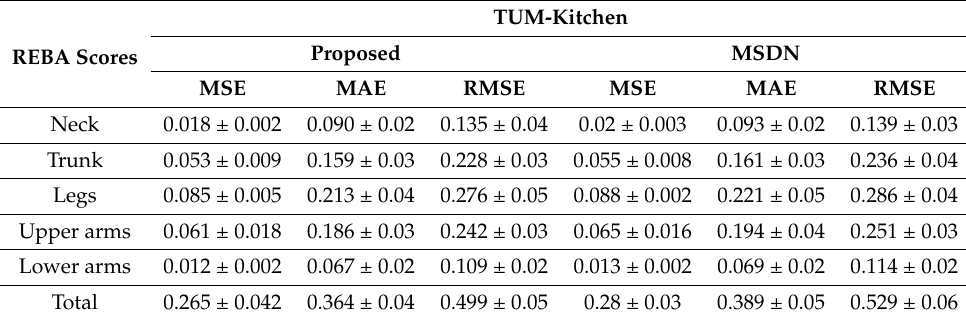
Table 5. Performance of the proposed method in terms of partial and total REBA scores in the TUM Kitchen dataset.